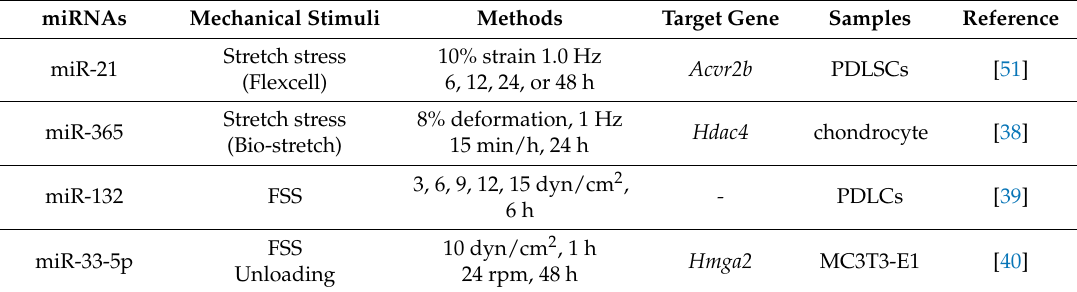
Table 2. Mechanosensitive miRNAs promote osteogenic